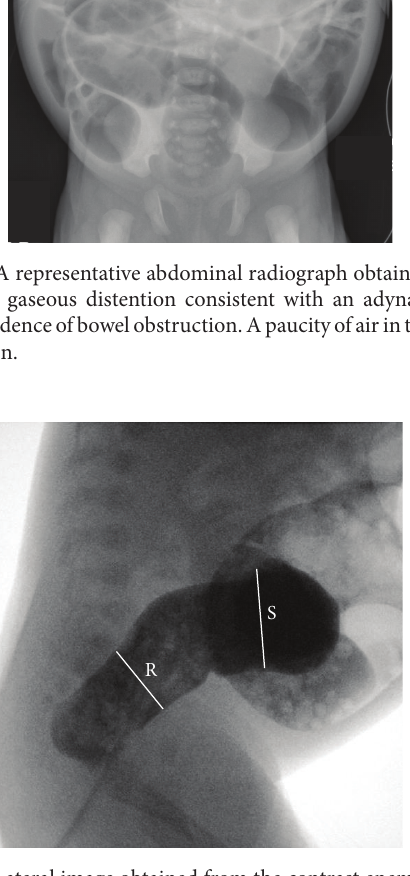
Figure 3: Lateral image obtained from the contrast enema demon- strated a mildly narrowed distal rectum (R) compared to a slightly larger caliber sigmoid colon (S). These results demonstrated a diminished rectosigmoid index although there was no apparent transition